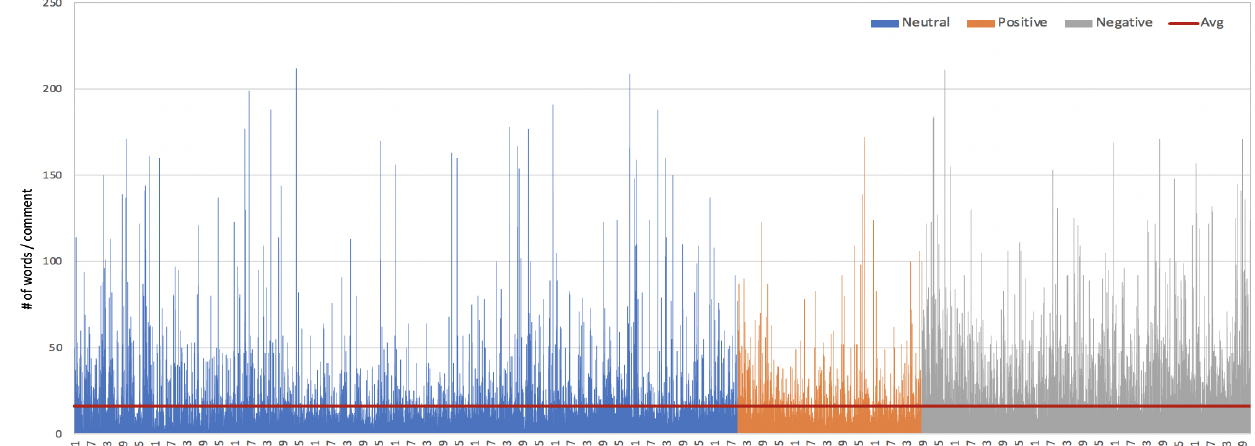
Figure 4. Length of comments among sentiment classes.